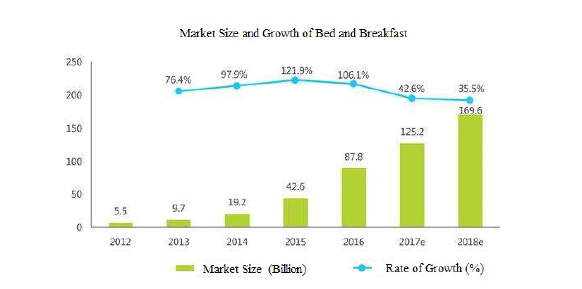
Fig. 2. The trade and growth of bed and breakfast